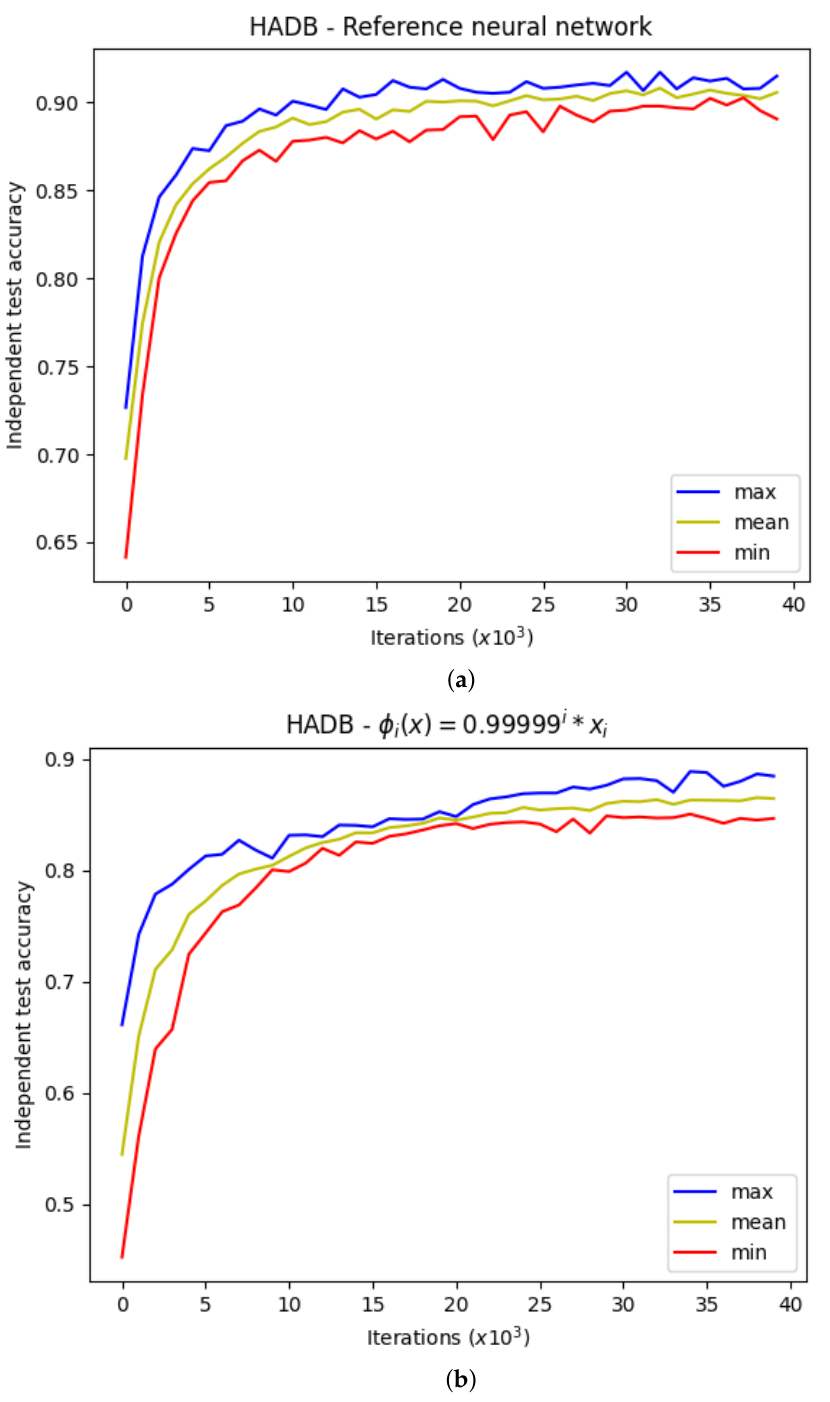
Figure 10. This figure plots the mean, minimal, and maximal classification accuracies during training, averaged from five independent training sessions on the HADB dataset. The top image ( a ) depicts the classification accuracies with the reference convolutional neural network (baseline), while the lower image ( b ) plots the same results using an SAW convolution-based kervolutional neural network with an attenuation parameter of 99,999. The blue color is the maximum accuracy, the yellow color is the mean accuracy, and the red line shows the minimum accuracy. As can be seen, there were no significant differences between the two